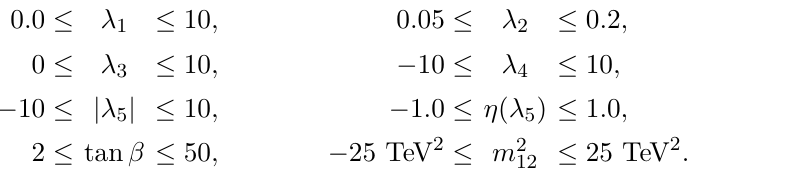
Figure 2 . Scatterplot of the allowed parameter space points in the projection of mass m H GeV) over tan β